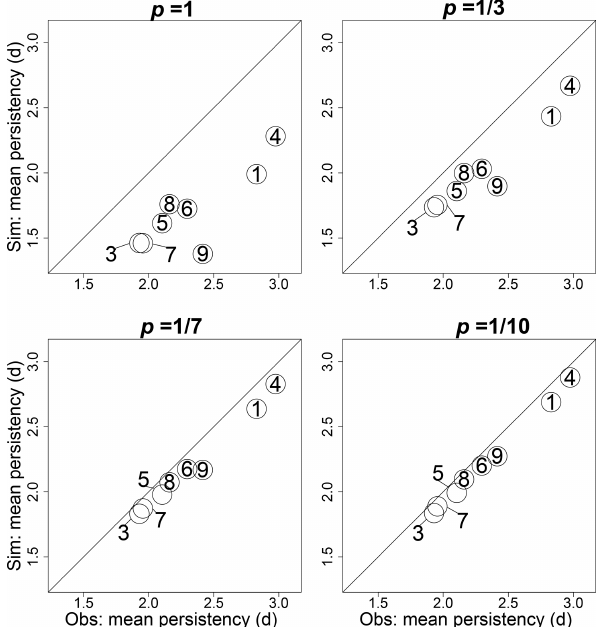
Figure 4. Mean persistency (in days) of each of the nine weather types (indicated by the different circles in each panel), as defined by Philipp et al. (2010), in the observed time series and in the simu- lated ones for transition probabilities ranging from 1 to 1 / 10 for the generation of atmospheric trajectories.